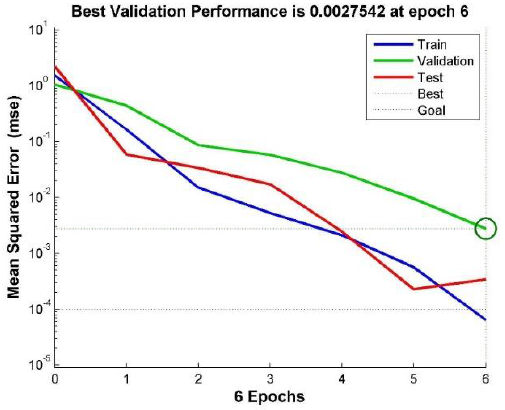
Figure 11. The network training results.